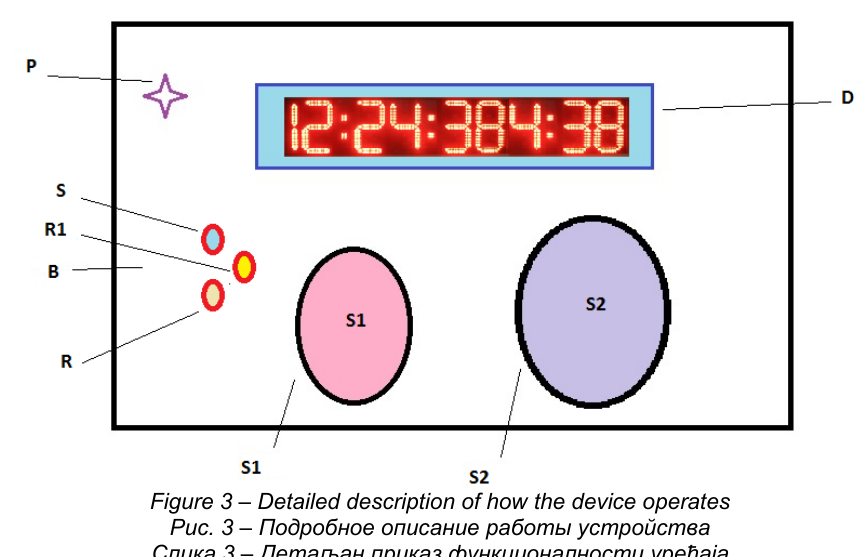
Figure 3 – Detailed description of how the device operates Рис . 3 – Подробное описание работы устройства Слика 3 – Детаљан приказ функционалности